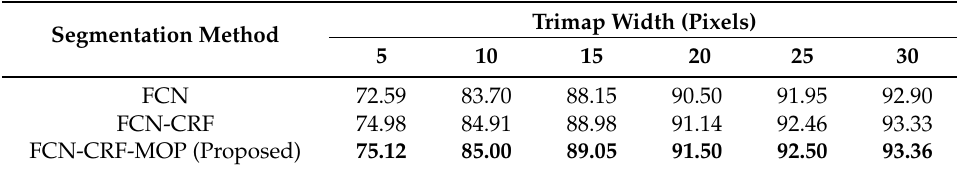
Table 2. Mean IoU of the compared methods within the trimap under varying widths. For each used trimap width, the highest result is highlighted in